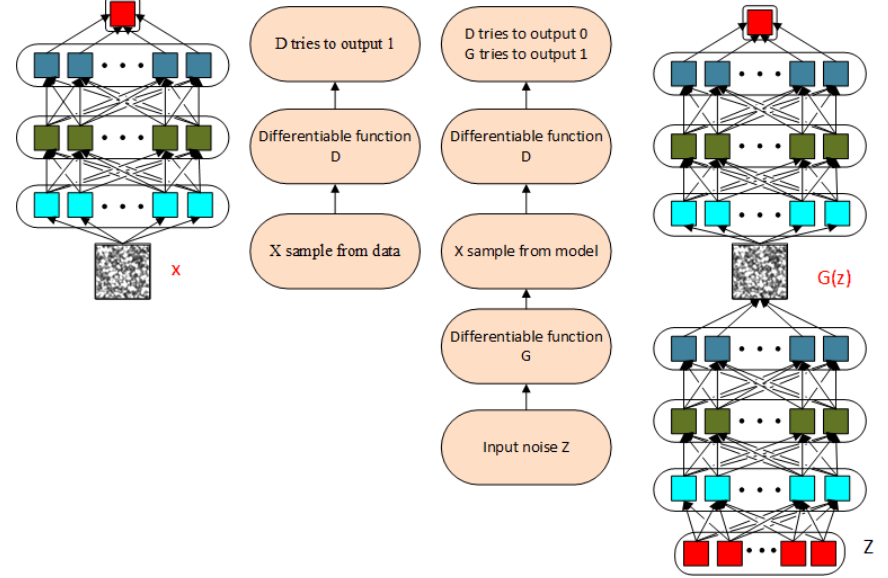
Figure 2. Schematic of a